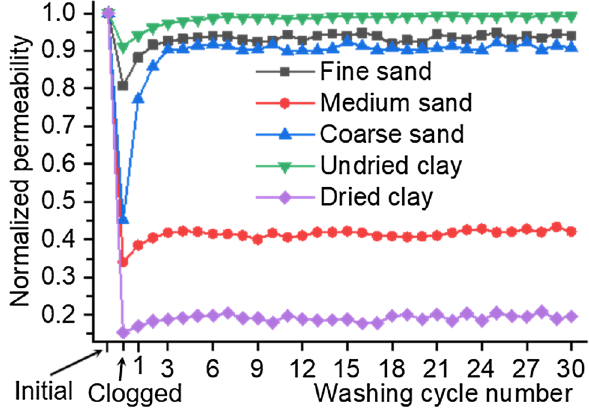
Figure 7. The normalized permeability versus the number of washing cycles.